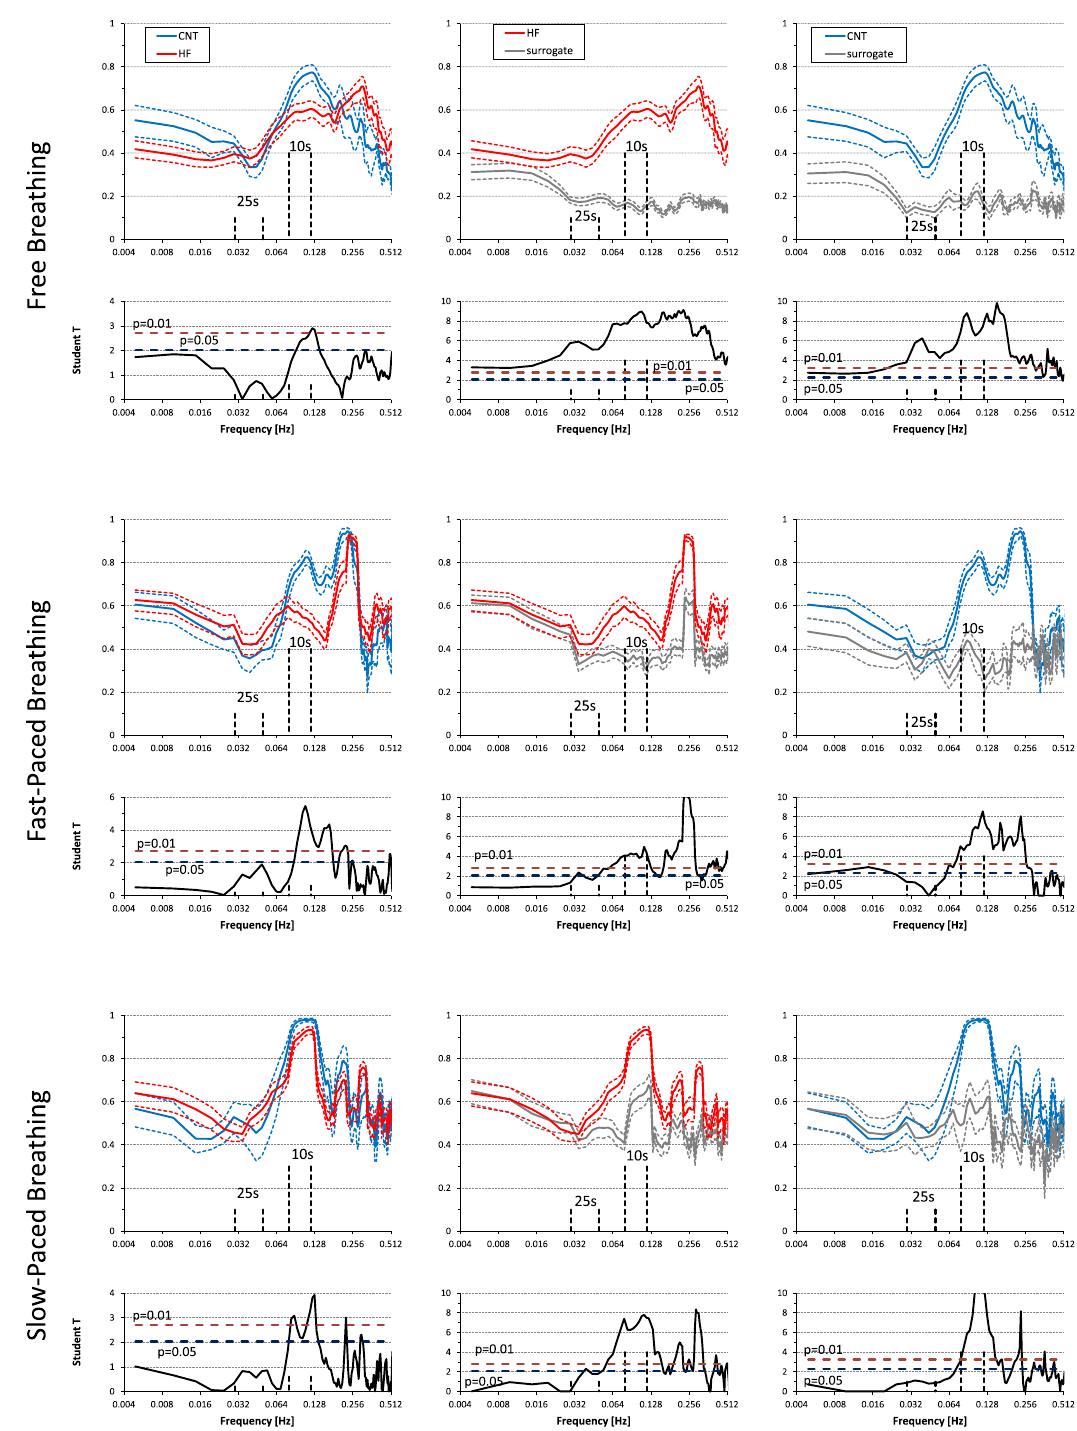
Figure 4. SBP–RRI coherency spectra during free, fast-paced, and slow-paced breathing. Coherency spectra as mean ± sem. Below each spectrum, the Student T between groups is shown at each frequency with horizontal dashed lines indicating the 0.05 and 0.01 significance thresholds. Left panels compare heart failure (HF) patients and controls (CNT): T-values above the dashed lines point out significant differences between groups. Central panels compare original and surrogate coherency spectra in the HF group while right panels compare original and surrogate coherency spectra in the CNT group: T-values above the dashed lines point out coherences significantly greater than 0. Note that the highest coherency occurs at frequencies around the 10-s rhythm and the lowest coherency at frequencies corresponding to fluctuations of about 25